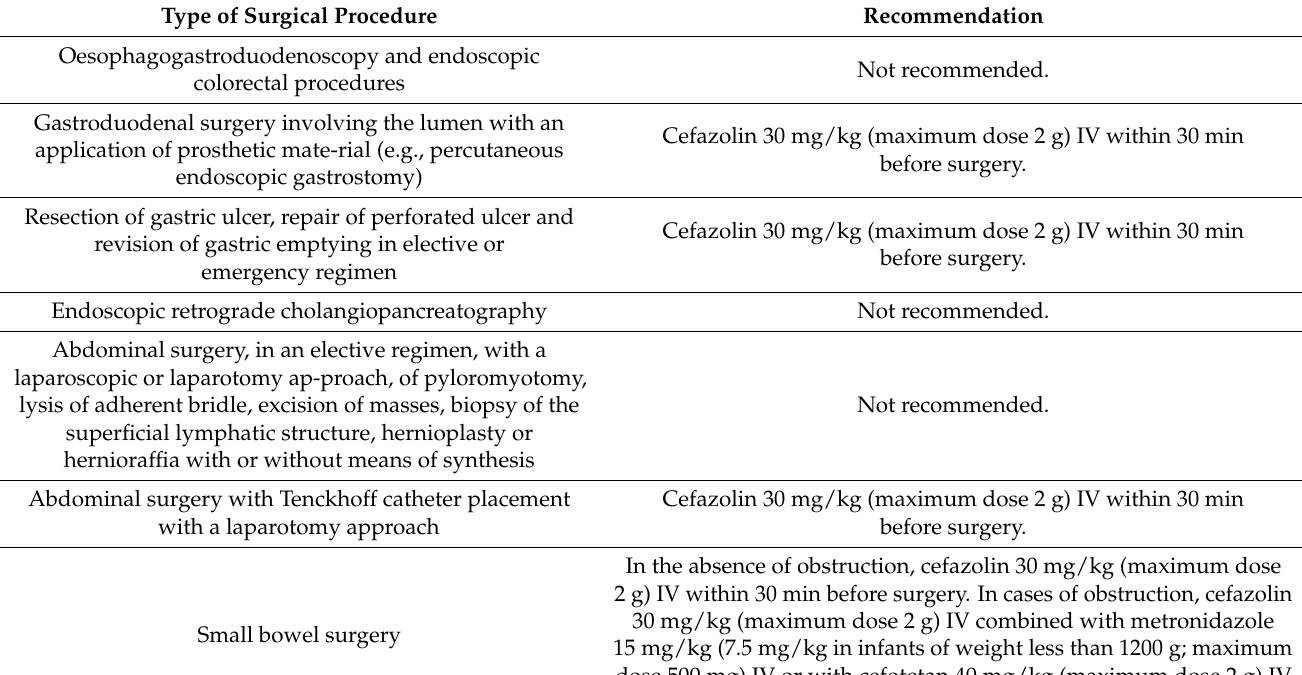
Table 2. Surgical antimicrobial prophylaxis in abdominal surgery for neonates and children.